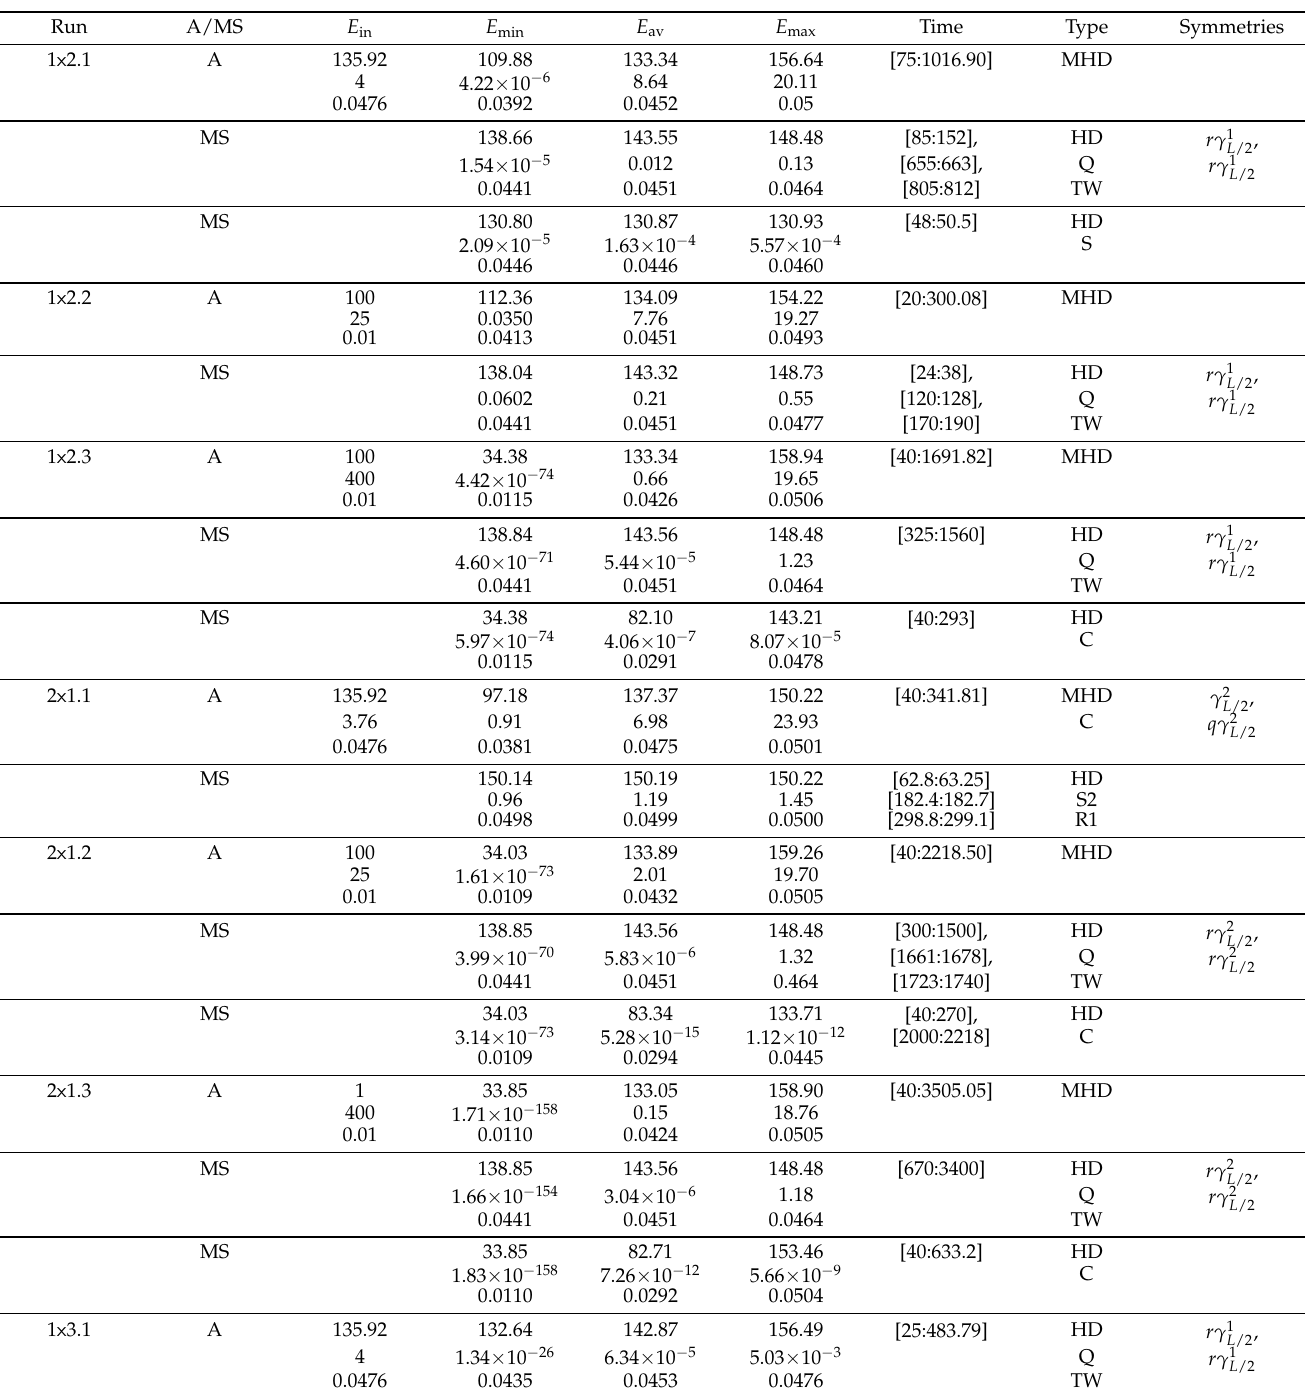
Table 2. Attractors (A, column 2) and metastable states (MS) in simulations in the ( M 1 , M 2 ) - periodicity boxes. Columns 3–6: kinetic, magnetic, heat (top to bottom lines in each cell of the table) initial, minimum, average and maximum energies, respectively, in the saturated regimes (A) or when the trajectory approaches the metastable states (MS). Column 7: time intervals when the trajectory is close to the attractor (the right end is then the time at which the run was terminated) or the metastable state. Column 8 (regime type): C—chaotic; HD—hydrodynamic;